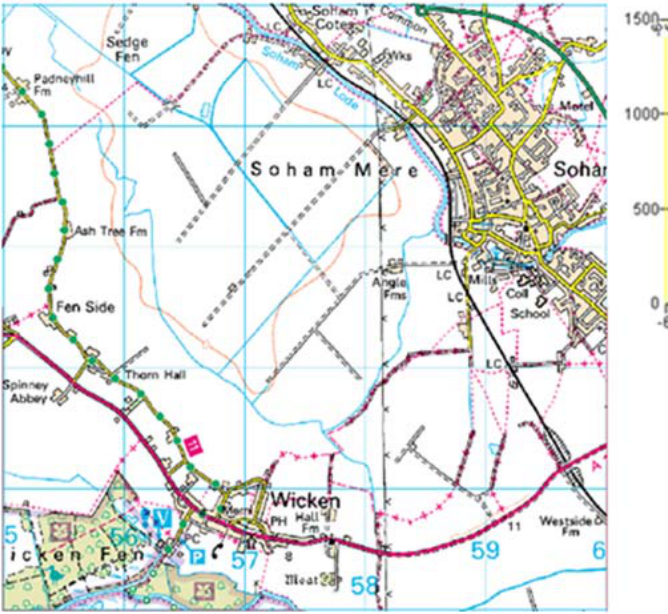
Figure 4b. Topographic Map of Wicken area (extremely level, low-lying - some, Soham Mere - below sea-level), arable and residential terrain)